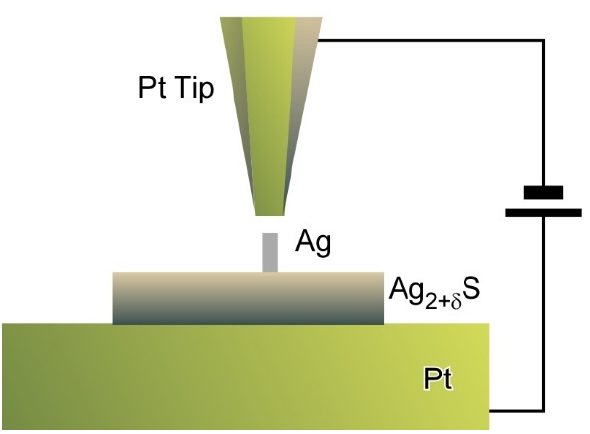
Figure 11. Nanoarchitectonics strategy to control the numbers of dopant atoms within solid elec- trolyte nanostructures using a Pt tip.